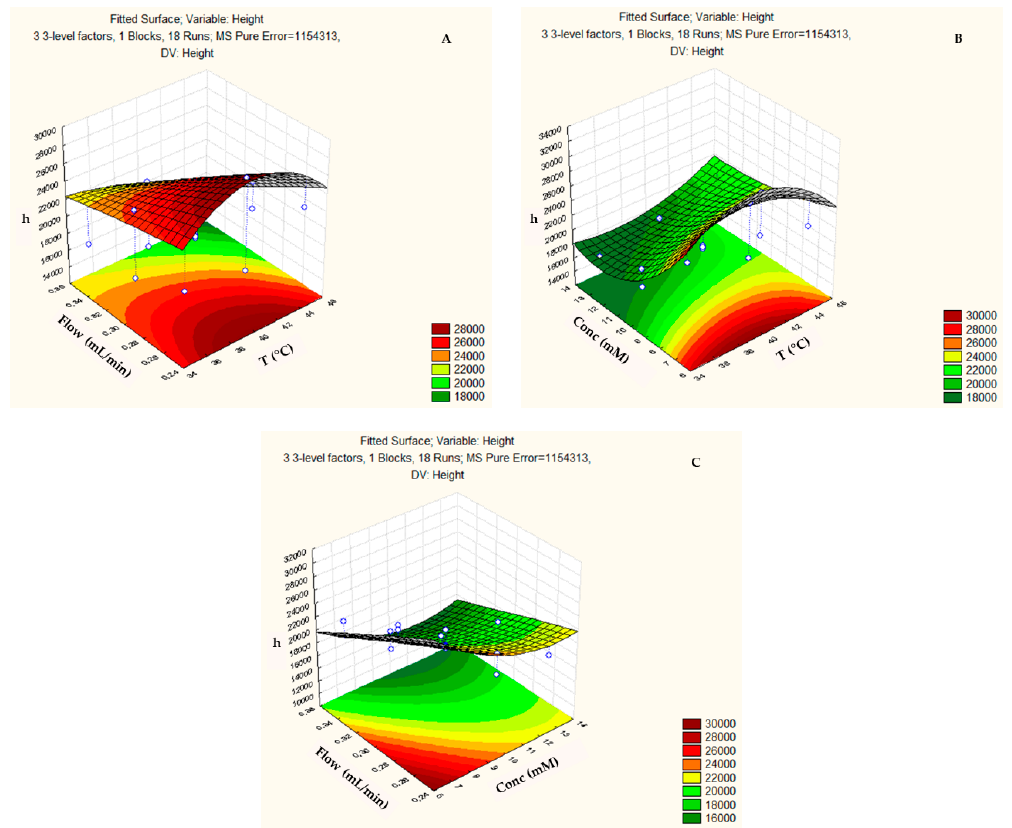
Figure 4. Three-dimensional response surface plot showing the e ff ects of the mutual interactions between two independent variables ( a ) Flow and Temperature; ( b ) Concentration and Temperature; and, ( c ) Flow and Concentration on height (h) of the chromatographic analysis on the ZIC-p-HILIC